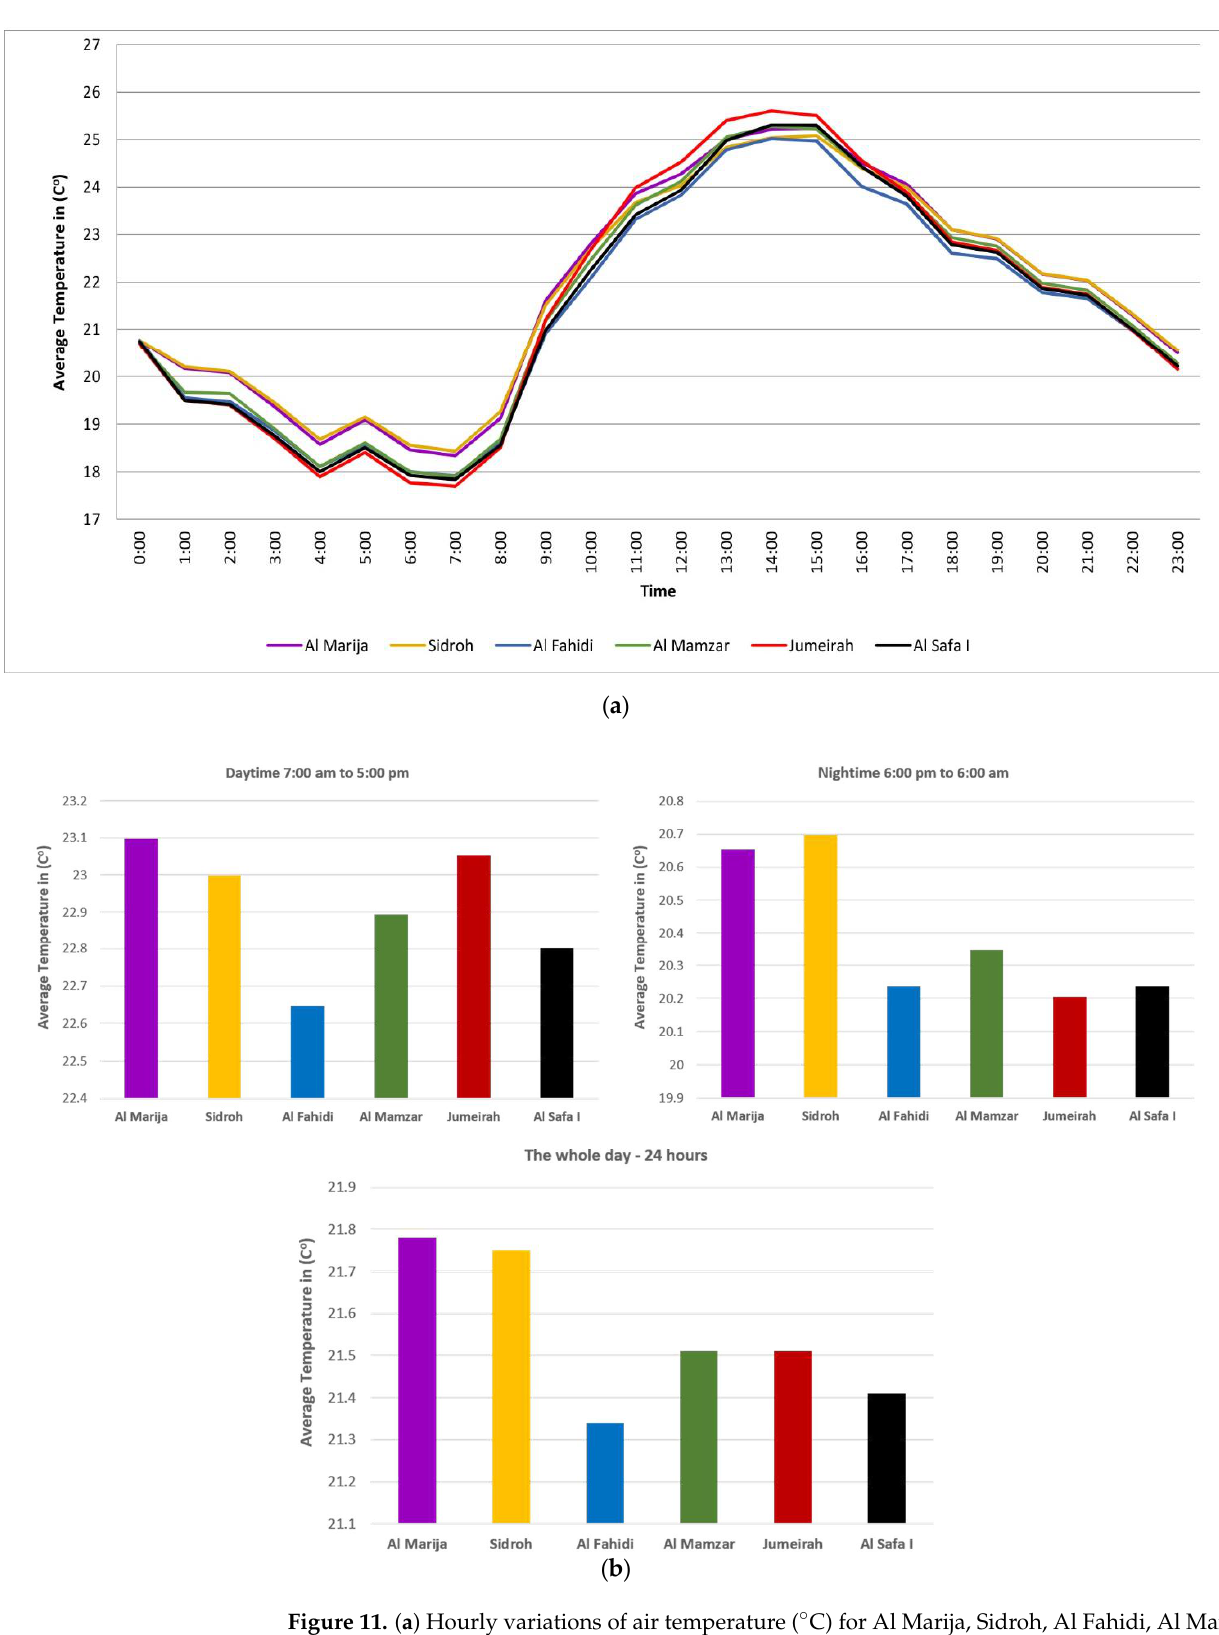
Figure 11. ( a ) Hourly variations of air temperature (˚C) for Al Marija, Sidroh, Al Fahidi, Al Mamzar, Jumeirah, and Al Safa I in December. ( b ) Average air temperature ( ˚ C) for daytime, nighttime, and the whole 24 h in December.